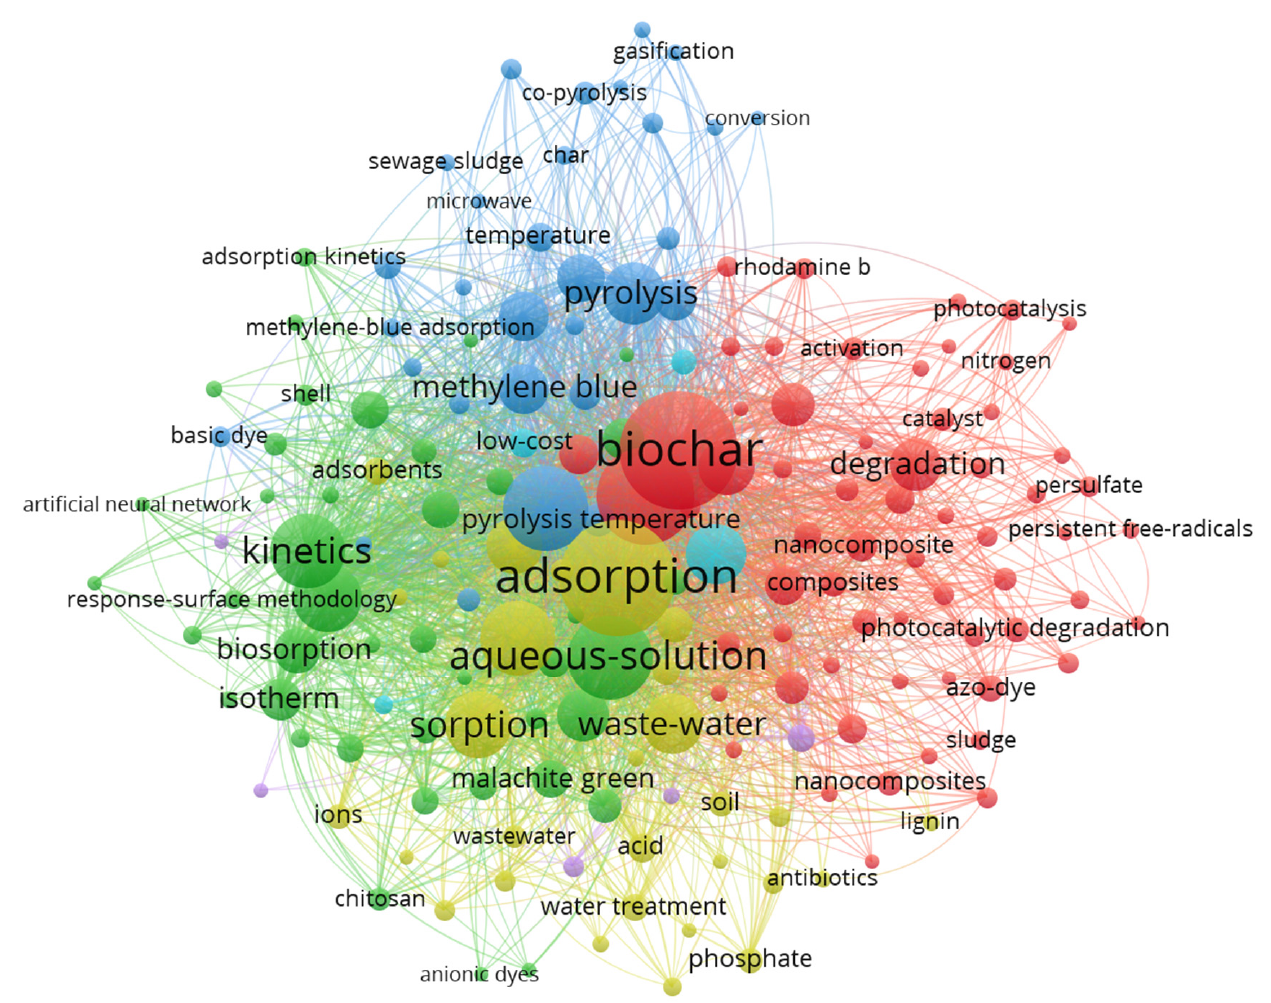
Figure 1. Network visualization of terms associated with biochar and dye.